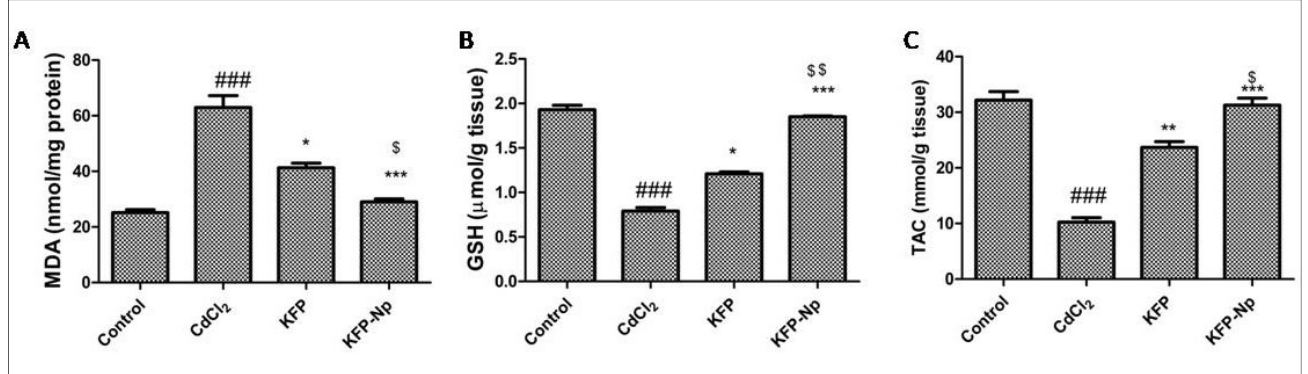
Figure 7. Effects of KFP-Np on CdCl 2 -induced level of MDA, GSH and TAC in liver tissue. ( A ) MDA, ( B ) GSH, ( C ) TAC were measured. Data are presented as means ± SD in each group ( n = 10). ### p < 0.001 significantly different from control group; * p < 0.05, ** p < 0.01 and *** p < 0.001, significantly different from the CdCl 2 group and $ p < 0.05 and $$ p < 0.01 significantly different from the KFP group. GSH: reduced glutathione; MDA: malondialdehyde; TAC: total antioxidant capacity.